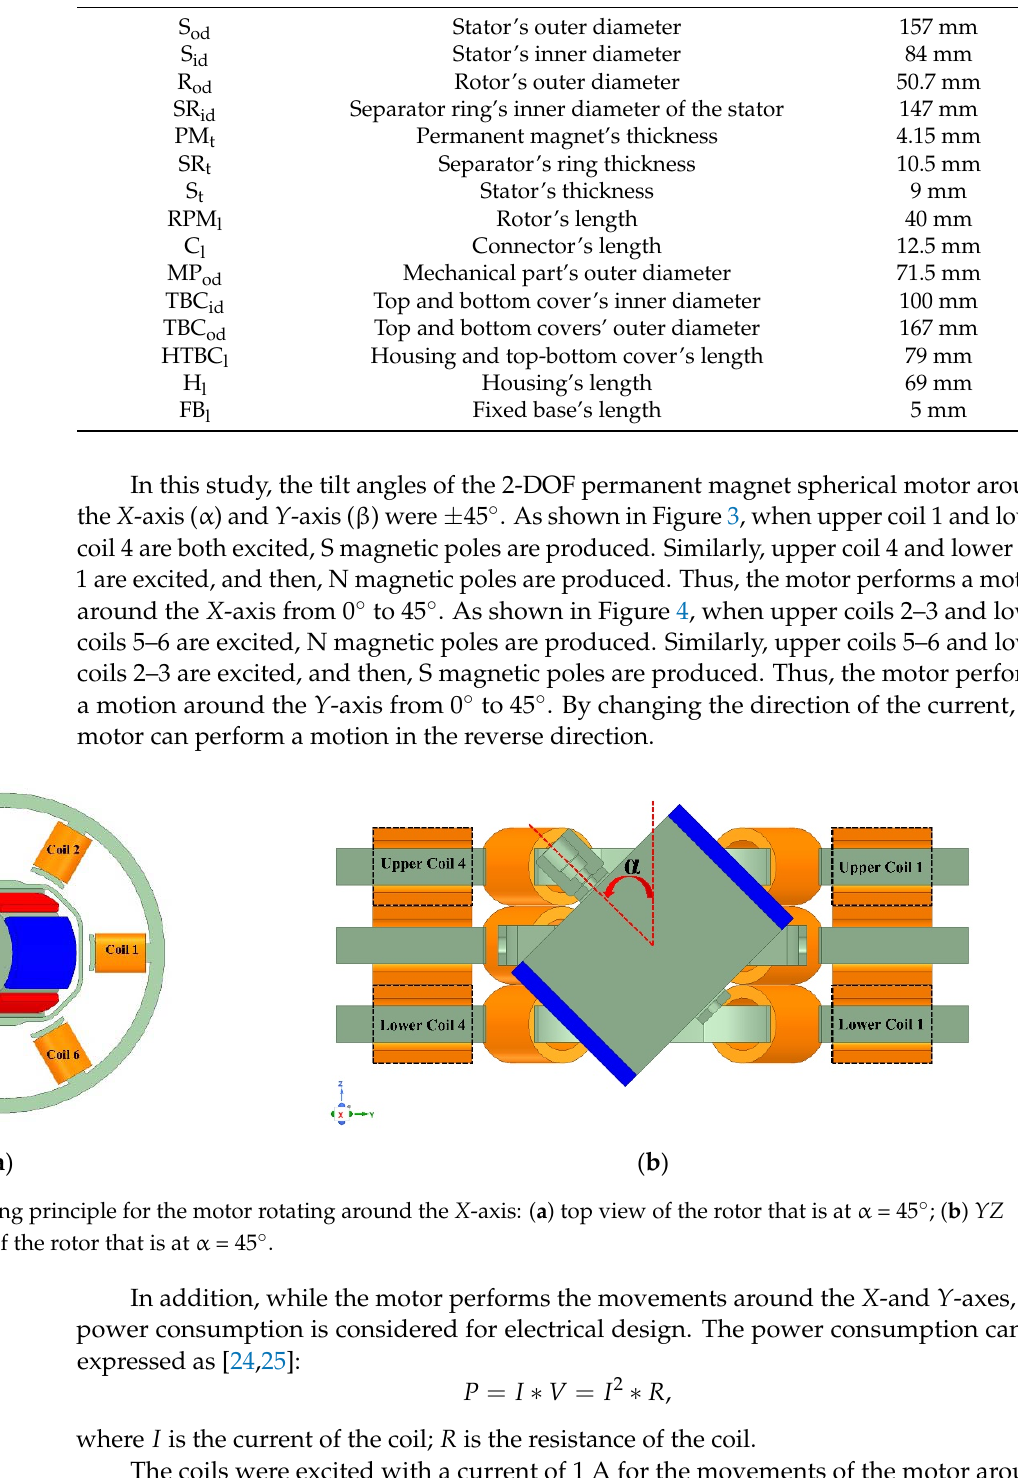
5 of 19 Table 1. Design parameters of the motor. Symbol